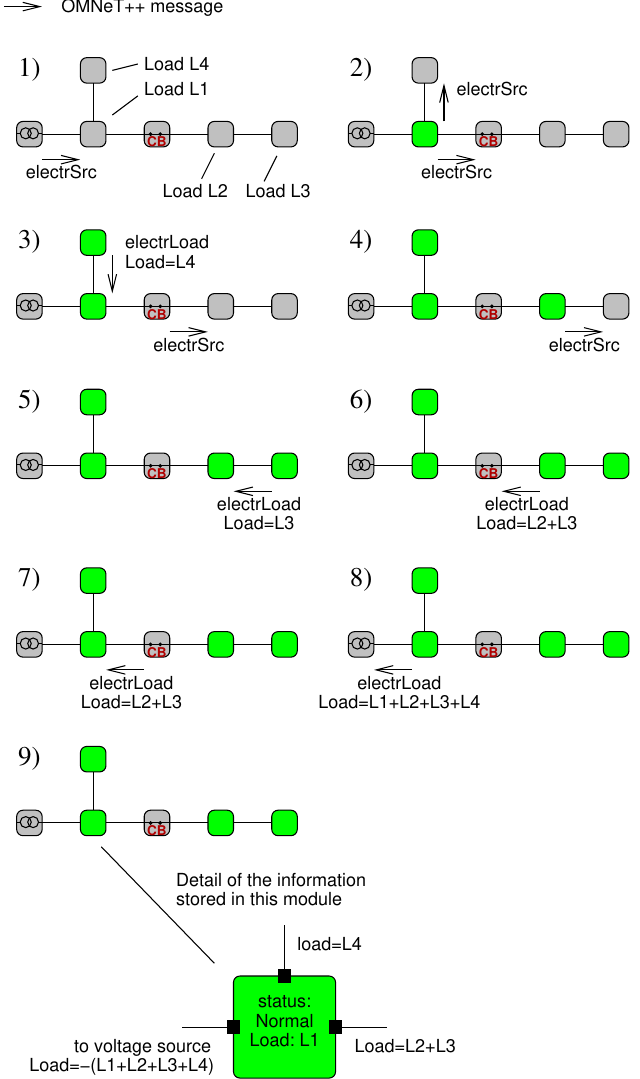
Figure 2. Steps (1)–(9) during the initialization of the electric